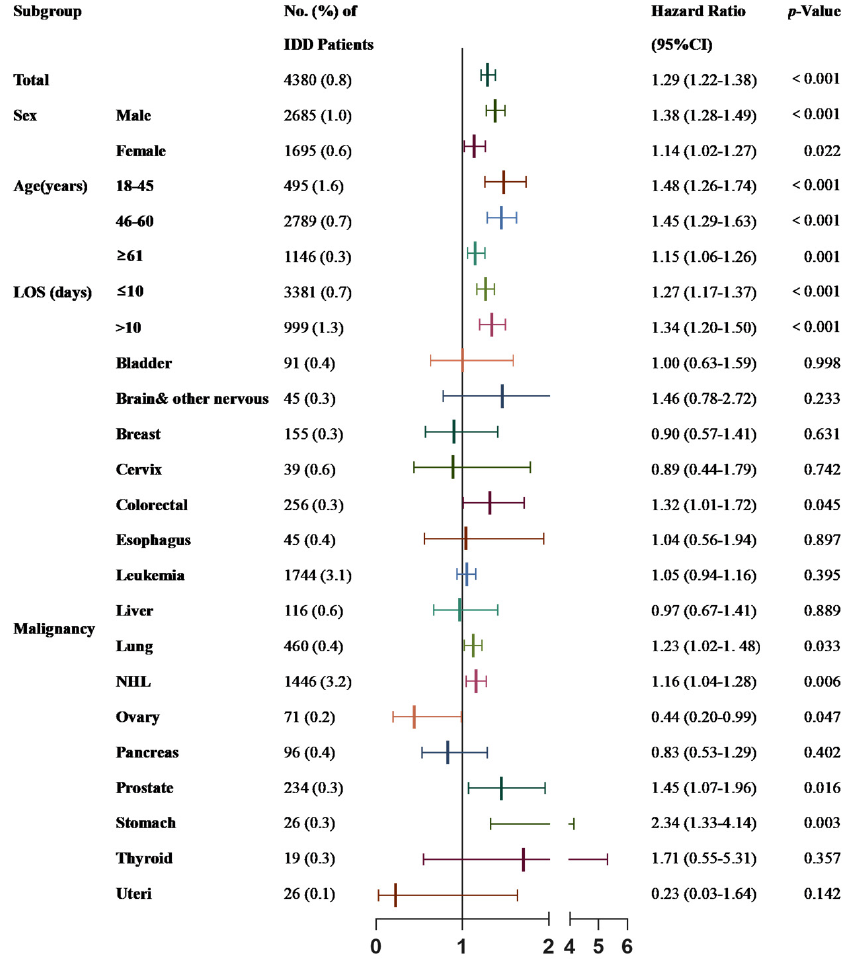
Figure 3. Malignancy patients with IDDs compared with those with NOIDDs of the 30-day un- planned readmission group.